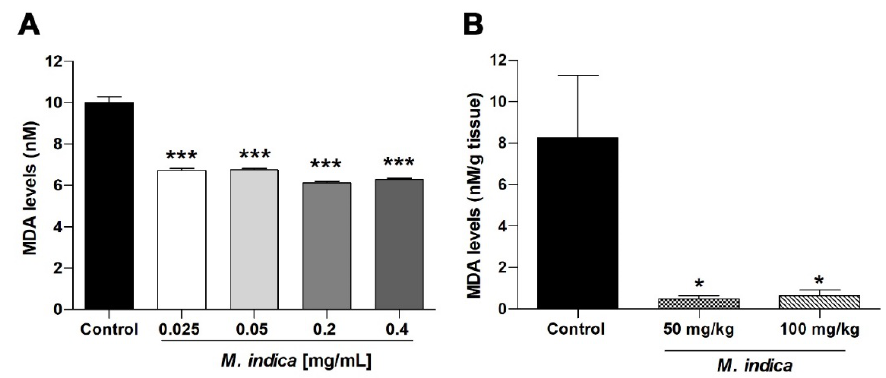
Figure7. Lyophilizedextractof M.indica (MIE)attenuatesoxidativestressbyreducinglipidperoxidation in-vitro and in-vivo. Panel ( A ) represent the test of TBARS for MIE in egg yolk homogenates, as a lipid-rich medium. In this case, the lipid peroxidation was induced by 2,2 (cid:48) -azobis(2-amidinopropane) dihydrochloride (0.07 M). Values represent the mean ± SEM of three experiments ( n = 3). In panel ( B ), malondialdehyde (MDA) levels was significantly reduced in ileal homogenate in both group of rats treatedwith50mg / kgand100mg / kgofMIE.Valuesrepresentthemeanofresponseinpercentage ± SEM of five experiments ( n = 5). * p < 0.05; *** p < 0.001 vs. control